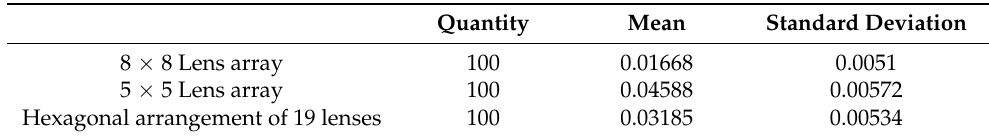
Table 4. Reconstruction accuracy statistics of 100 combination aberrations with certain weights by three arrangement